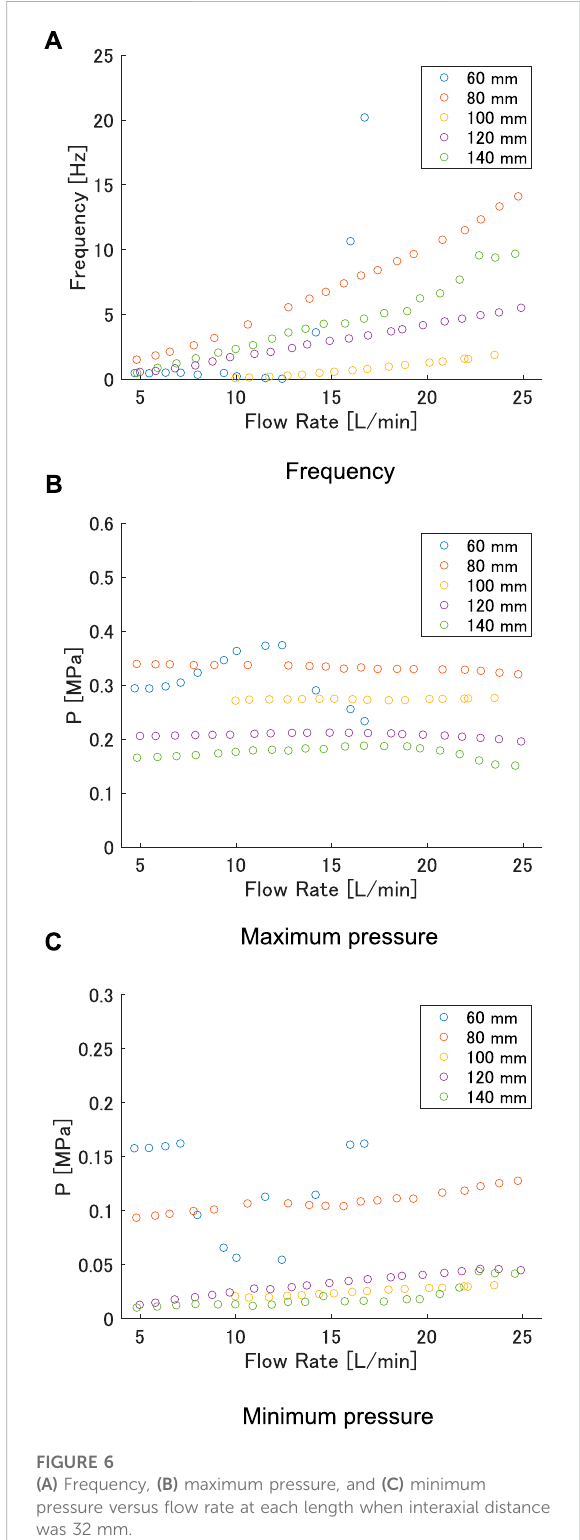
(cid:129) :Vibrating at some fl ow